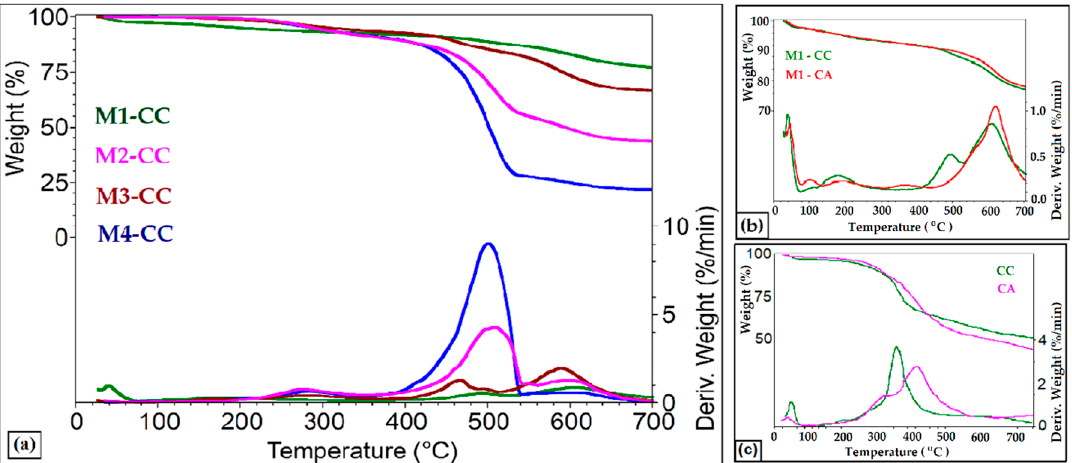
Figure 4. Thermogravimetric curves of hybrid materials, with different siloxane host matrices ( a ) or different dyes ( b ) and pure dyes ( c ).